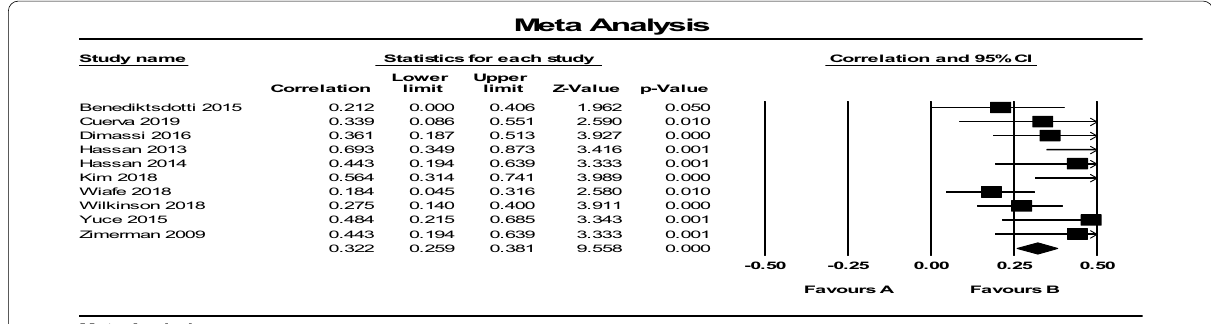
Fig. 3 Average intra-tester and inter-session reliability of ICC between ultrasound measurements and digital examinations of cervical